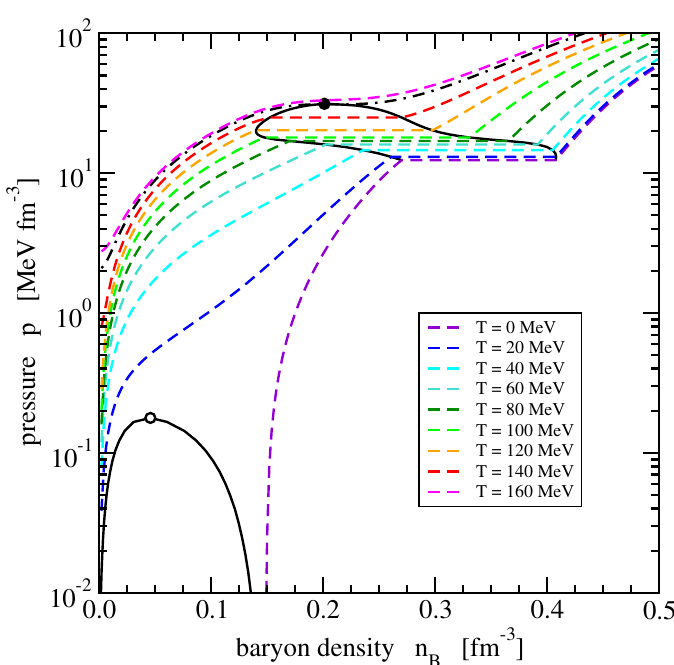
Figure 1. Isotherms in isospin-symmetric strongly interacting matter in the pressure–baryon density diagram at temperatures from 0 to 160 MeV in steps of 20 MeV (dashed colored lines) and at the critical temperature T crit of the pseudo hadron–quark phase transition (black dot-dashed line). The binodals and critical points are denoted by full black lines and a full (open) circle of the pseudo hadron–quark (liquid-gas) phase transition,